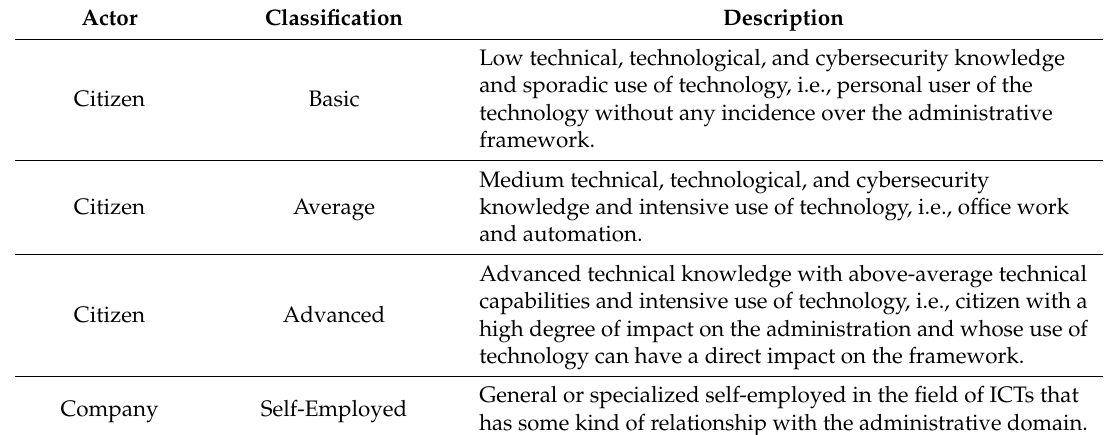
Table 1. Classification of the different actors within the administrative domain.